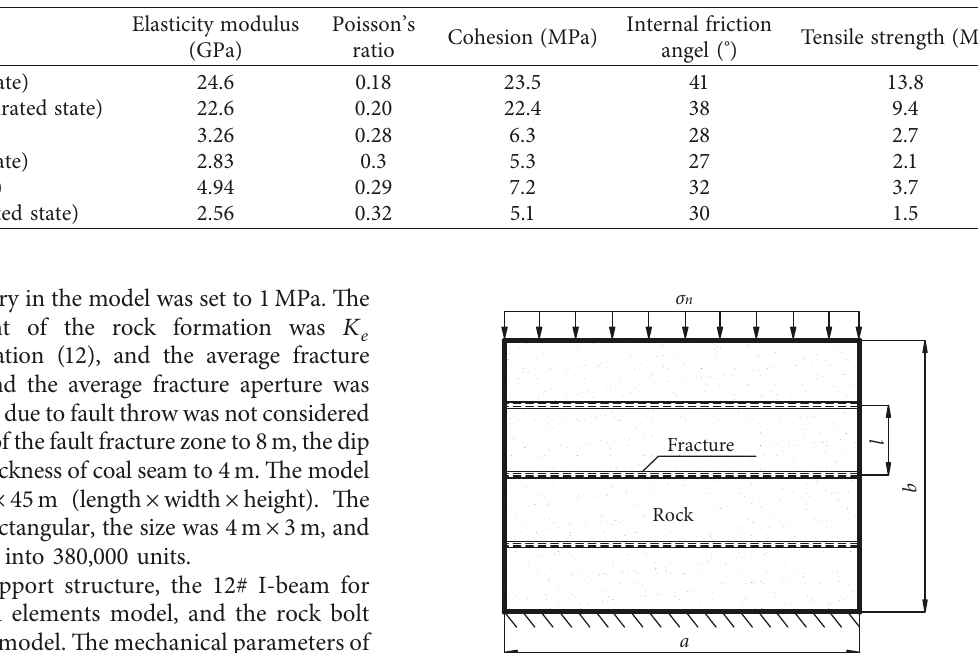
Table 1: Mechanical parameters of rock strata.